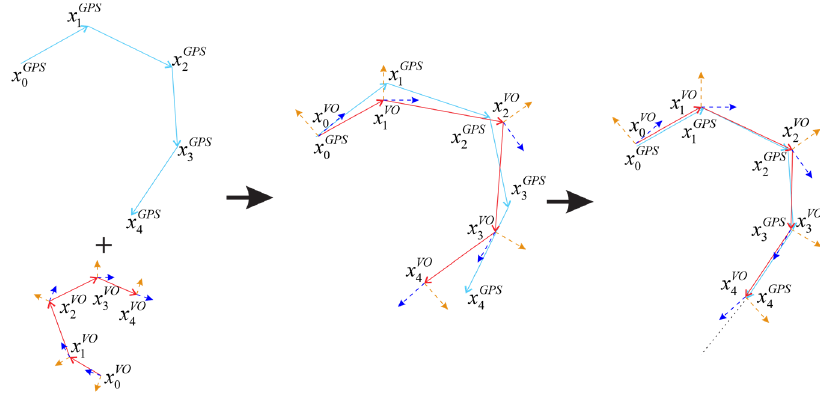
Figure 1. The diagram of integrating Visual Odometer and Global Position System (GPS).